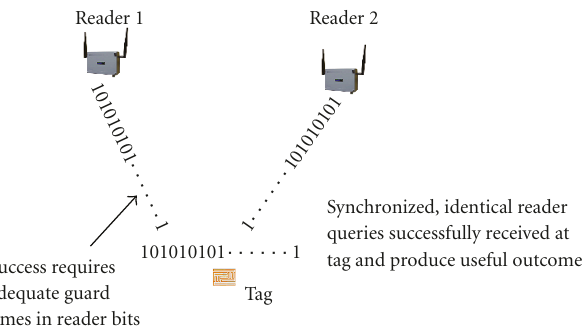
Figure 4: Figure showing that the same reader query bits at an overlapped tag result in correct query